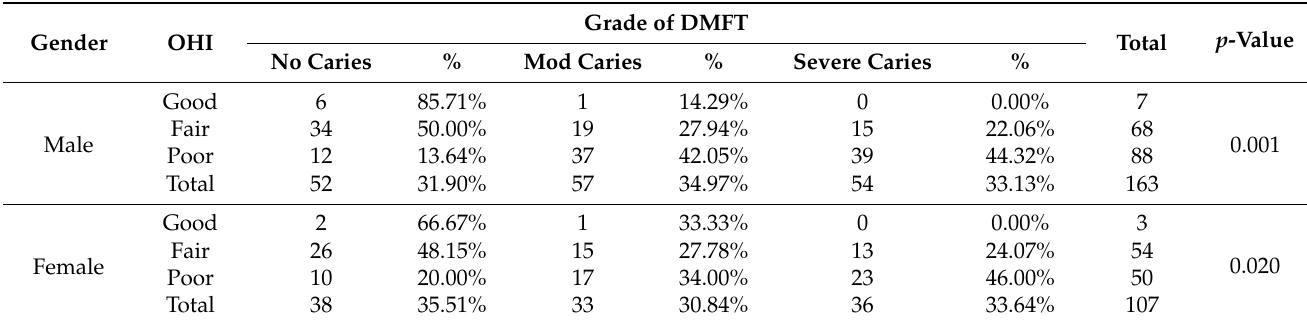
Table 7. Chi-square association test between grades of DMFT and OHI -S in terms of gender in total